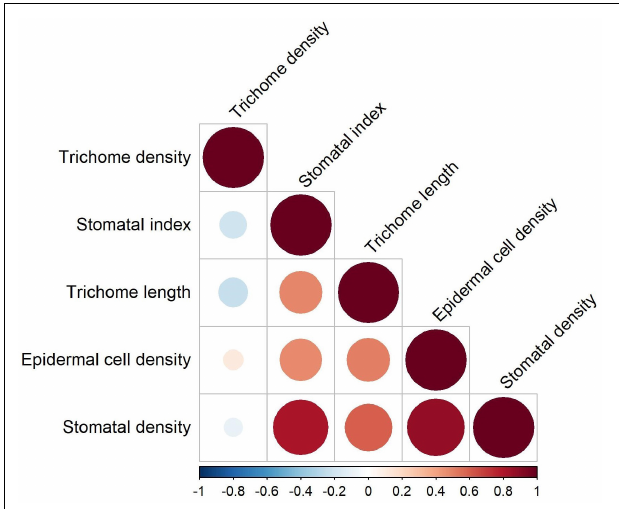
FIGURE 5 | Correlations between five micromorphological traits on the adaxial and abaxial leaflet surfaces of wild and cultivated lentil.